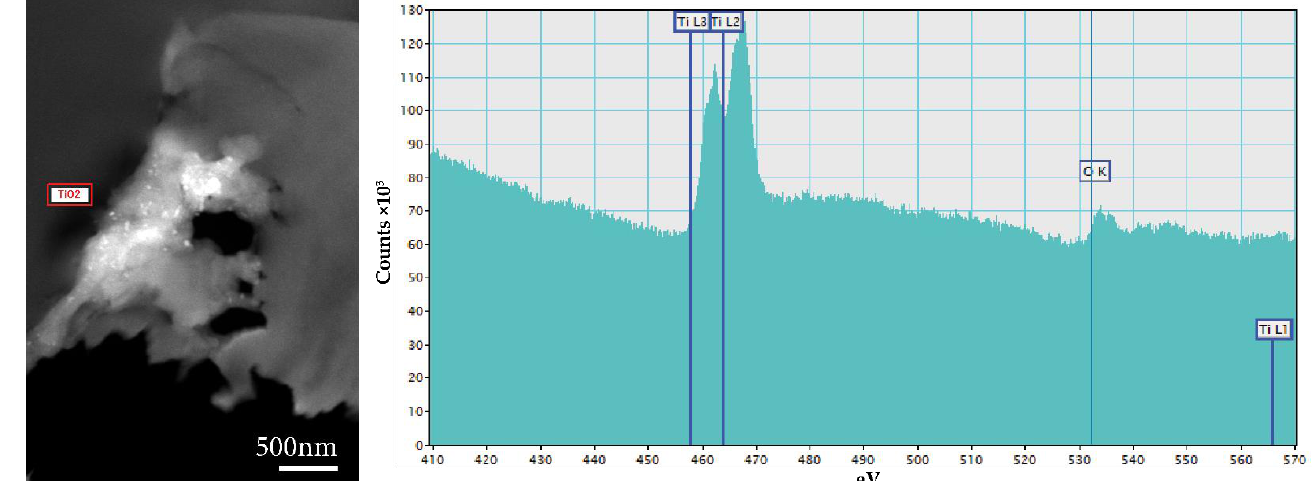
Figure 19. TEM micrograph of TiO 2 cluster in the coated and irradiated sample of beech wood ( left ), and EELS spectrum of TiO 2 ( right ).